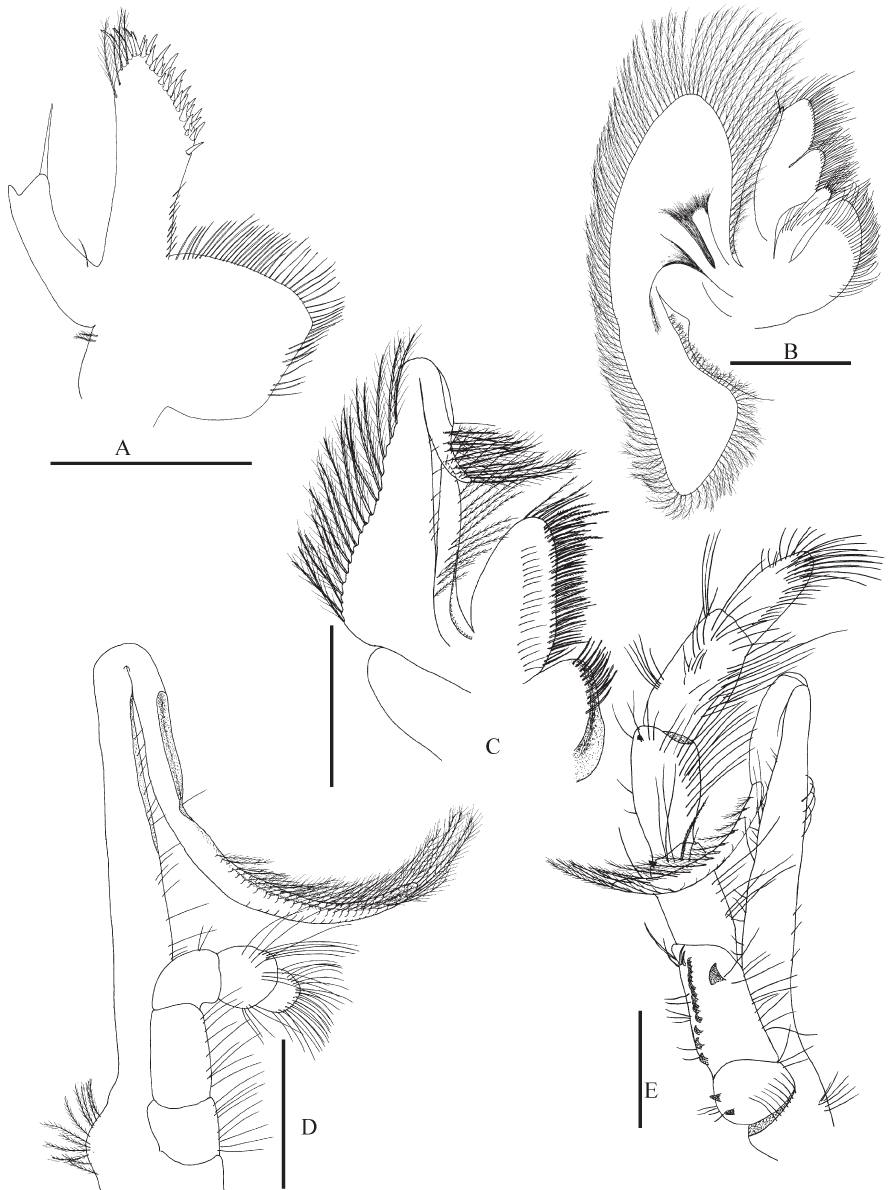
of small spines; dorsomesial margin unarmed; dorsola- teral margin with row of small teeth or spines.